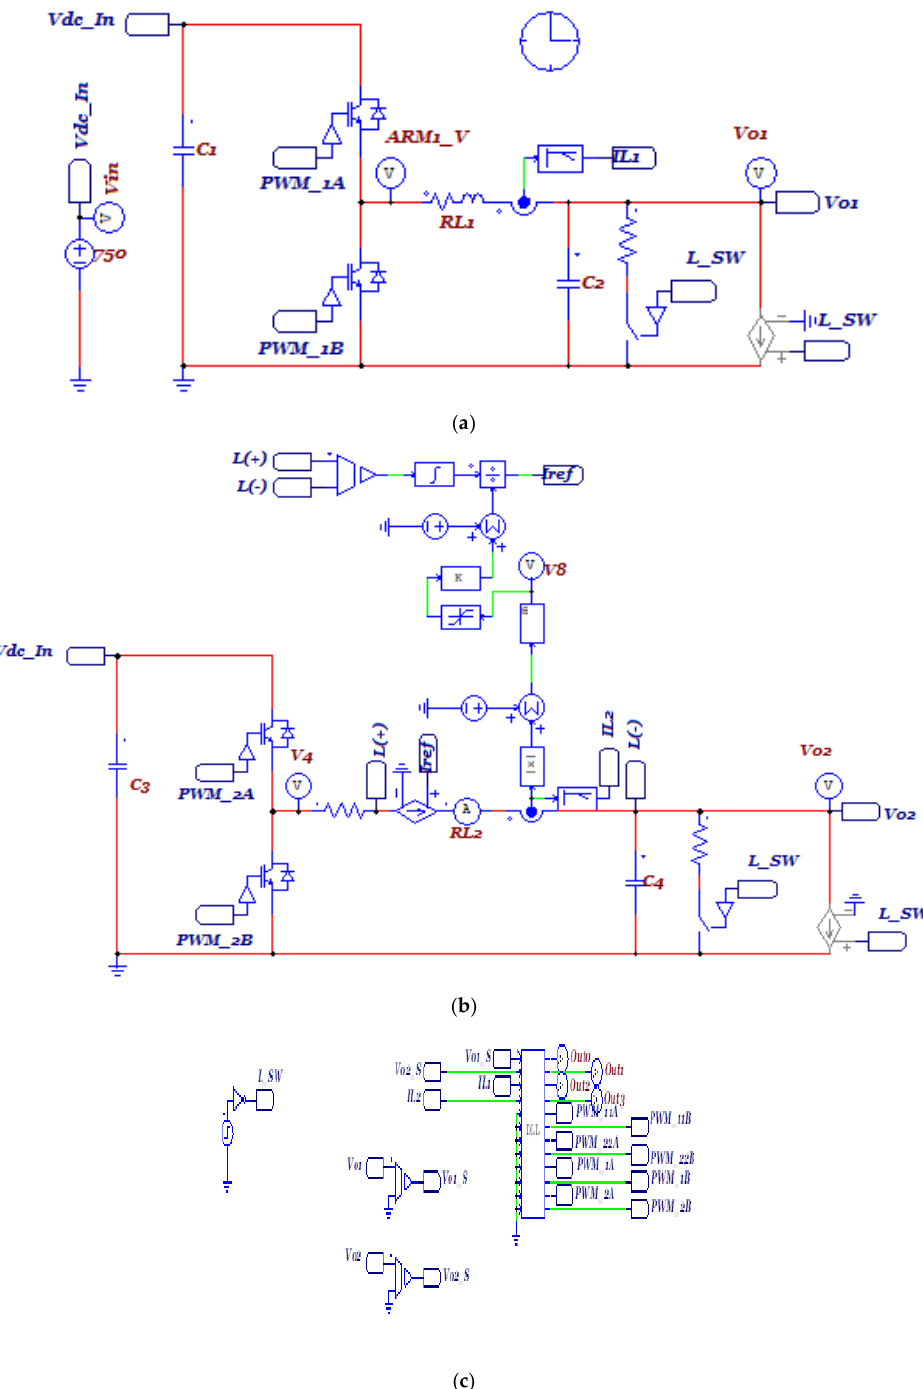
Figure 6. Simulation schematic. ( a ): Conventional bidirectional boost-buck converter. ( b ): Proposed heterogenous reactor bi-directional boost-buck converter. ( c ): Control DLL block